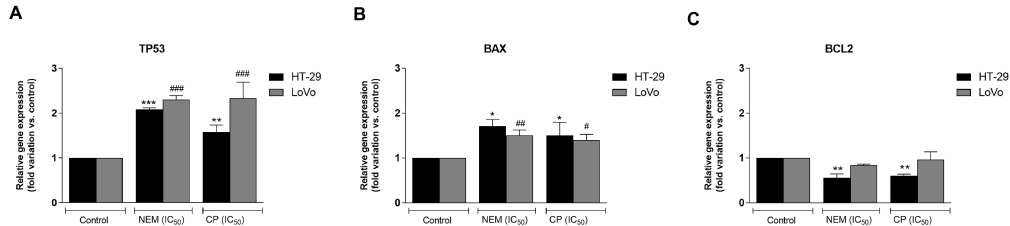
Figure 5. E ff ect of NEM and CP (IC 50 / 72 h) on apoptosis-related genes of CRC cell lines. The mRNA levels of P53 ( A ), BAX ( B ) and BCL2 ( C ) are expressed as fold of change vs. control. Data are expressed as mean ± S.D. of three independent experiments. HT-29 cells: * p < 0.05, ** p < 0.01, *** p < 0.001 vs. untreated cells. LoVo cells: # p < 0.05, ## p < 0.01, ### p < 0.001 vs. untreated cells.